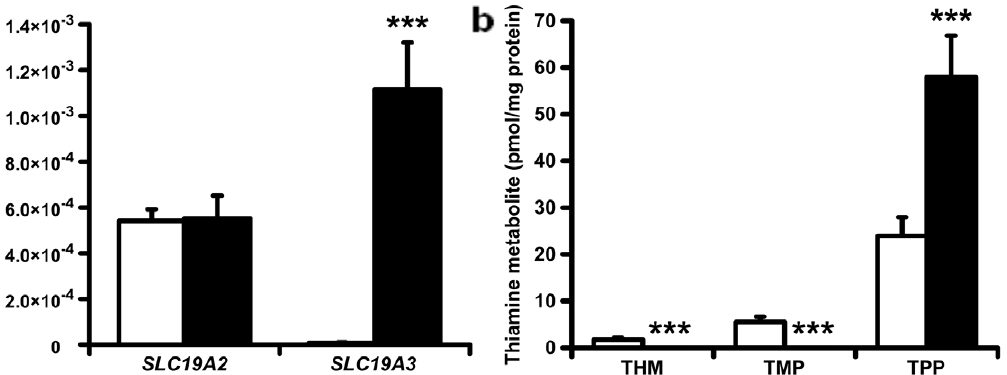
Figure 3. Comparison of thiamine transporter expression and thiamine metabolites in human kidney cells and HK-2 cell line. a . SLC19A2 and SLC19A3 mRNA. Key: HK-2 cells (hollow bars) and human kidney cortex (filled bars). The bar for SLC19A3 mRNA in HK-2 cells is 122-fold lower than for human kidney cortex. b . Cellular metabolites of thiamine. Key: HK-2 cells (hollow bars) and hPETCs (filled bars). Thiamine and TMP in hPTECs were lower than the limits of detection. Data are mean 6 SD (n=4 and 8 for a and b respectively). Significance: ***, P , 0.001 (with respect to HK-2 cells).